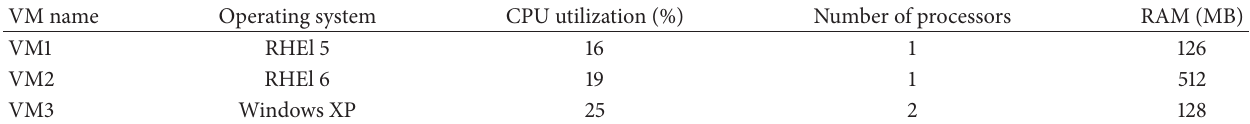
Table 10: Local list of node 1 (S1).